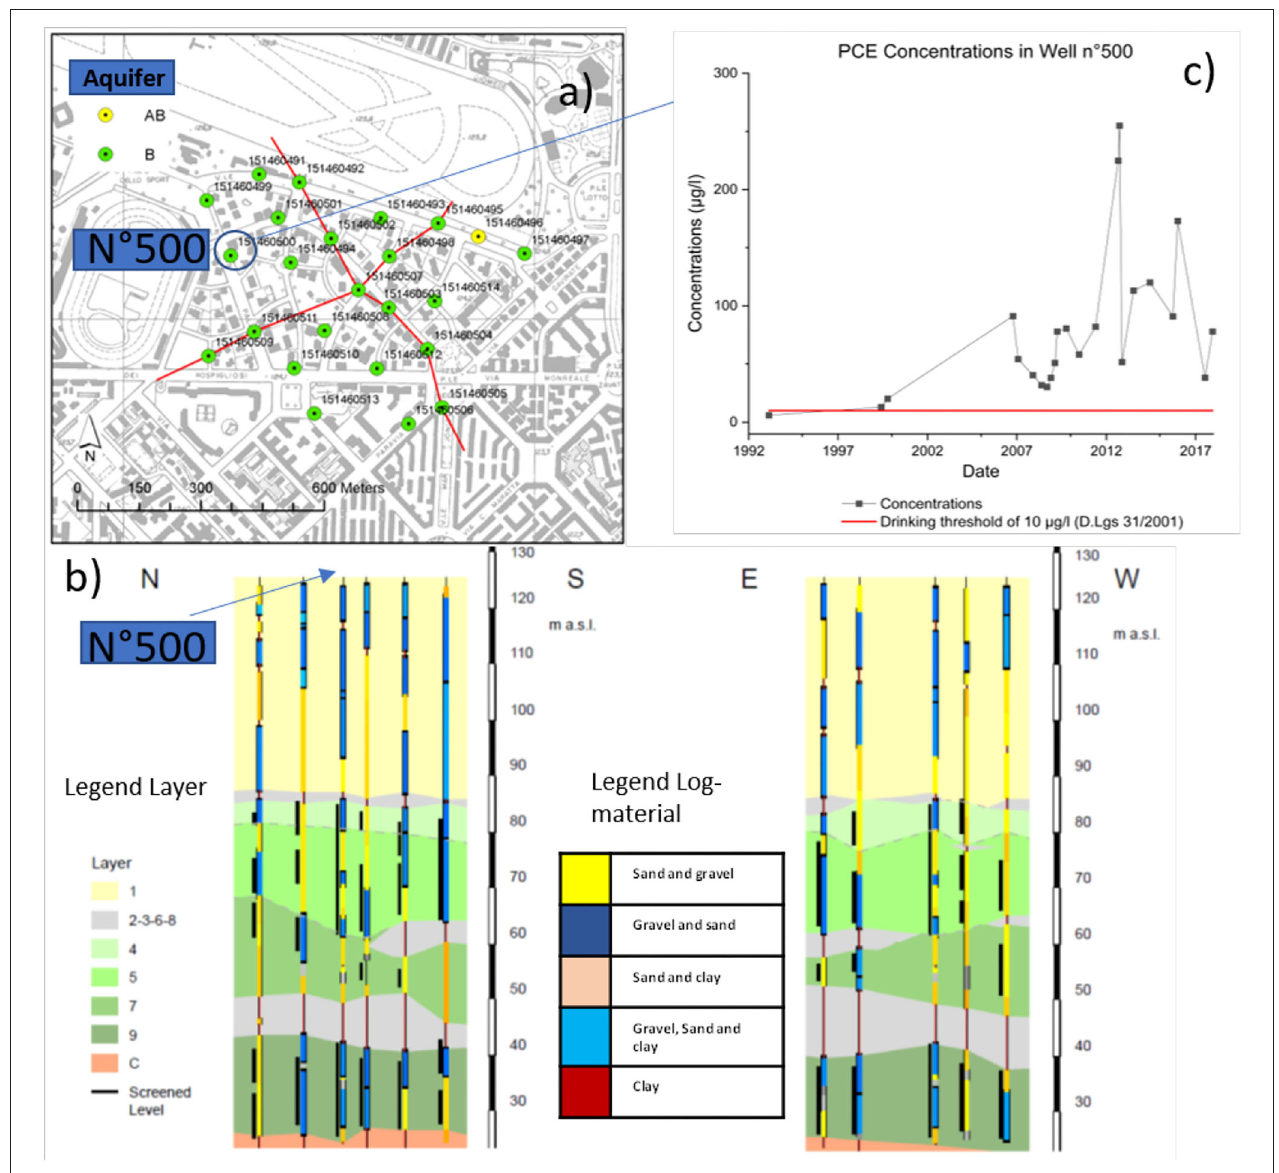
FIGURE 4 | Technical layout of the San Siro pumping station: (a) position of the San Siro pumping wells, (b) cross-sections reporting stratigraphic well logs (the colors along each well represent the different materials); the color in the cross-section represents the different layers and (c) the PCE concentrations for the period 1992–2017 in well N ◦ 500 where the particles were